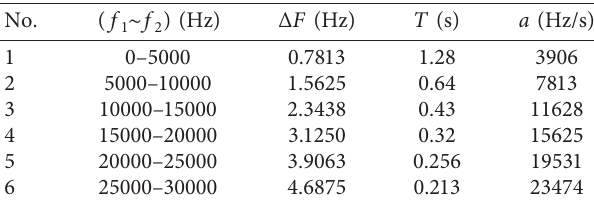
Figure 5: The averaged pseudofrequency response function. Table 1: Frequency bandwidth and frequency resolution.